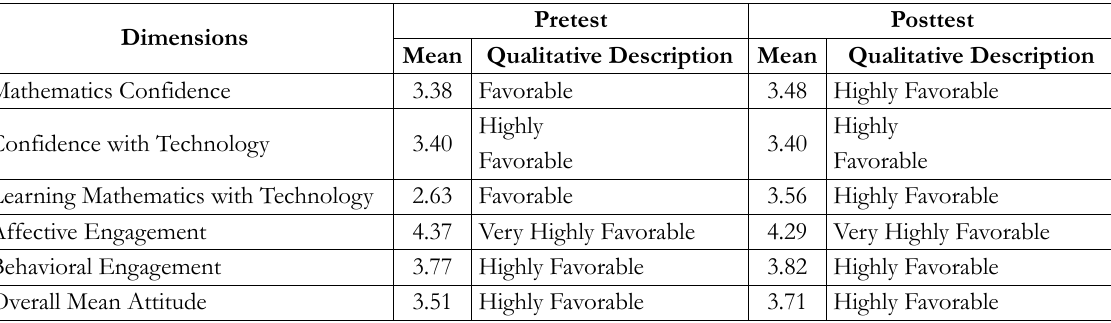
Table 6. Students’ Overall Attitude Toward Learning Mathematics with